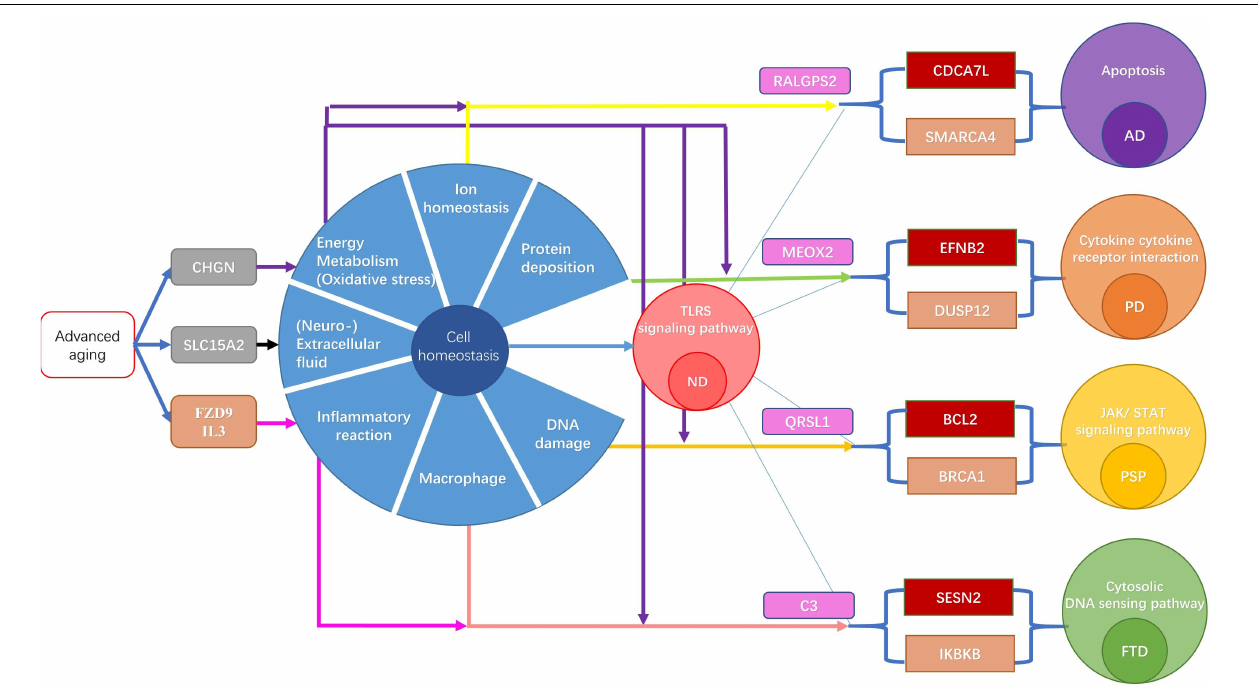
FIGURE 8 | The mechanism of ND induced by acceleration aging. The brown gene is a biomarker of ND. The gray gene is the top MCMC marker of aging. The red gene is the top MCMC marker of each ND type. The pink gene is the network node with highest betweenness. The yellow arrow indicates the connection of Calcium homeostasis. The purple arrow represents a link to DNA damage repair response. The green arrow represents the link with the mitochondrial function. The brown arrow represents a link to oxidative stress. The black arrow indicates the connection with ubiquitin. The red arrow indicates the connection of the intracellular